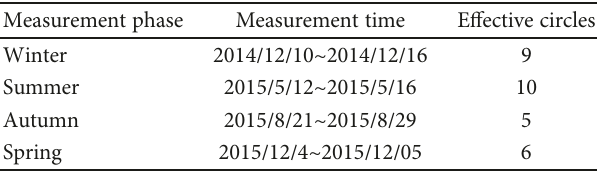
Table 1: Measurement time and e ff ective circles per